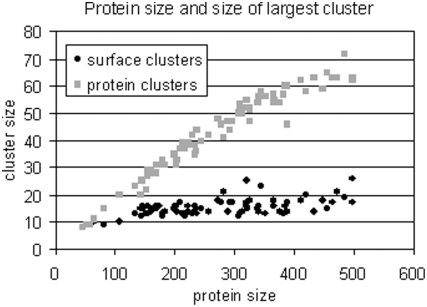
Protein size and size of the largest cluster.Sizes of the largest protein cluster (grey) and of the largest surface
cluster (black) are plotted for all proteins in the Huang dataset. Size
is defined by the number of residues.